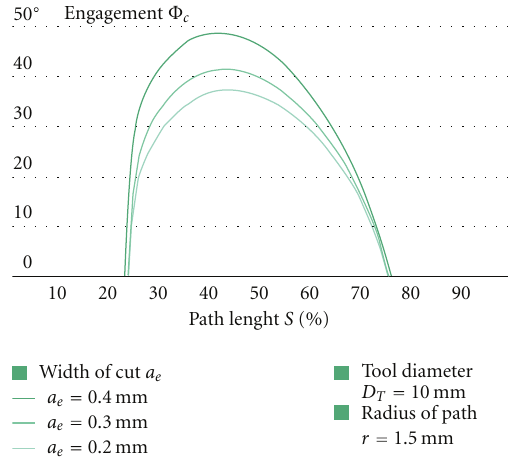
Figure 4: Influence of the cutting width a e